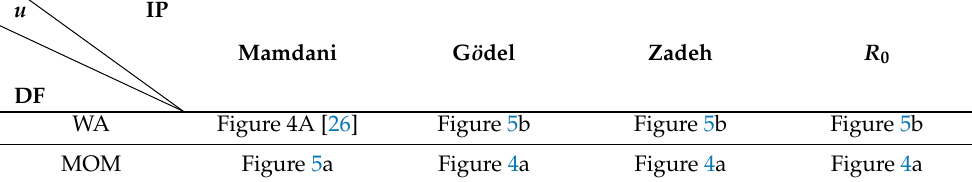
Table 2. Three-dimensional surface diagrams of control variable by different triple I algorithm.